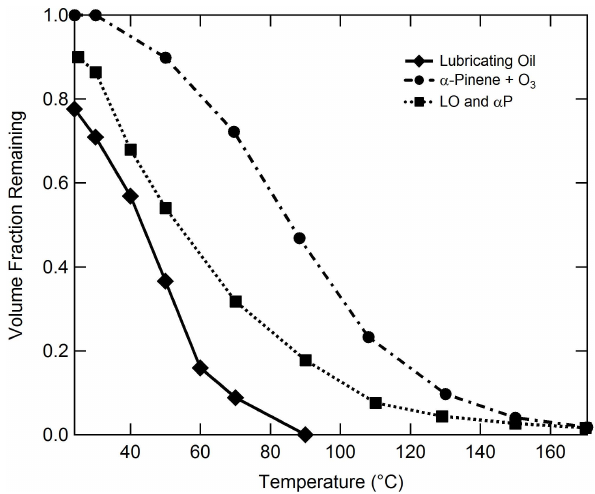
Fig. 2. Mass thermograms for LO aerosol ( (cid:7) ), α P aerosol ( • ) and the LO/ α P mixture ( (cid:4) ). In the mixed particles, the LO is observed to disappear rapidly as temperature is increased while the α P spec- trum remains nearly